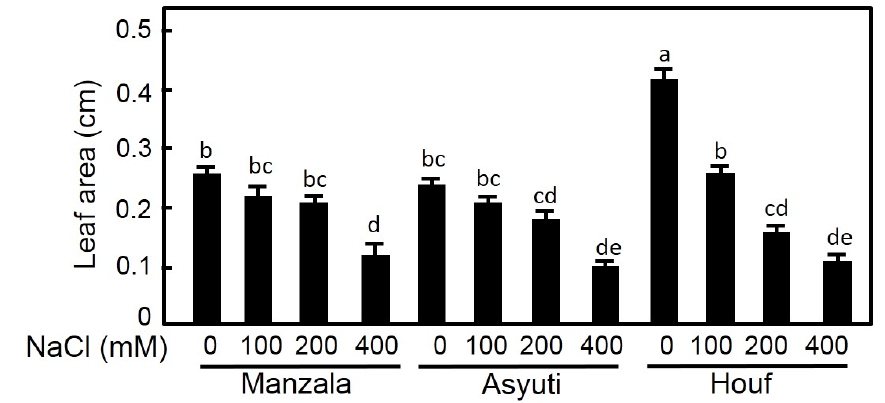
Figure 5. Influences of different salt concentrations (0, 100, 200 and 400 mM NaCl) on shoot length in Z. coccineum for 45 days. Value represents the mean of 5 replicates ± standard error, p -value < 0.05. For variables denoted with the same letter, the difference is not statistically significant.